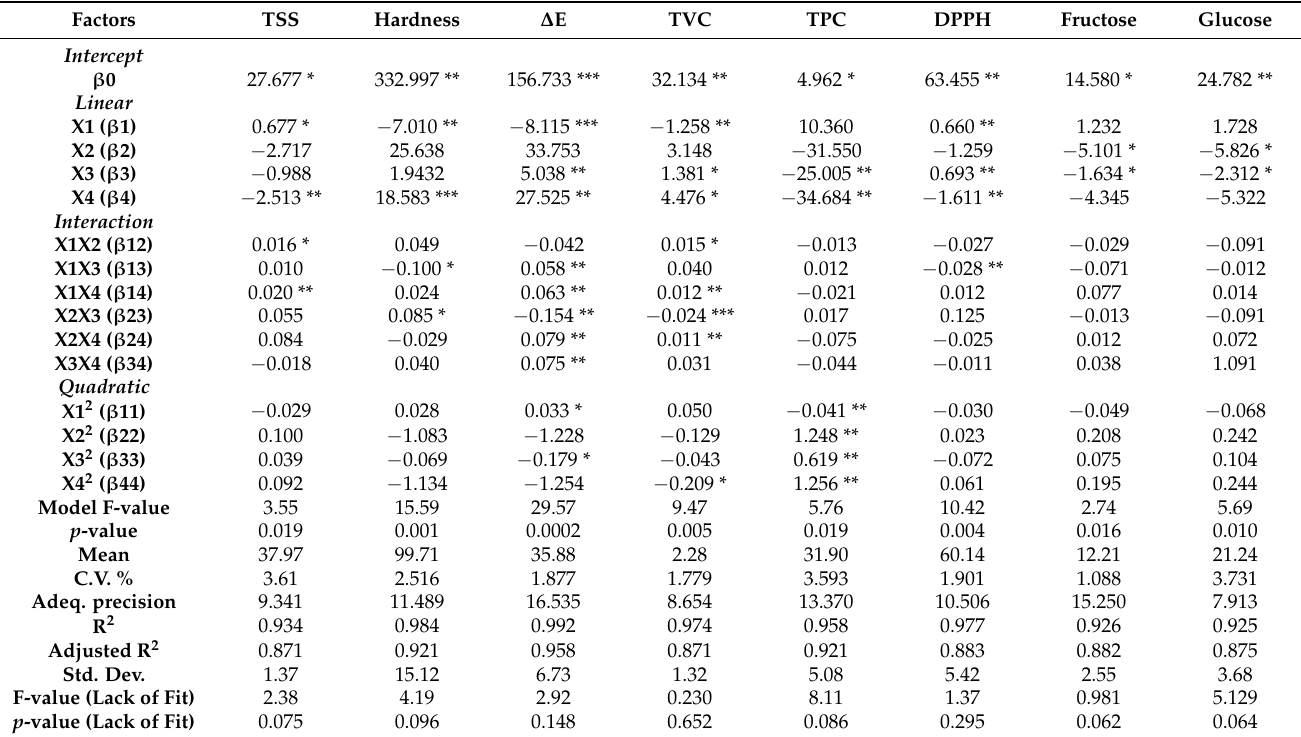
Table 1. Ultrasound Regression coefficients for process variables and product